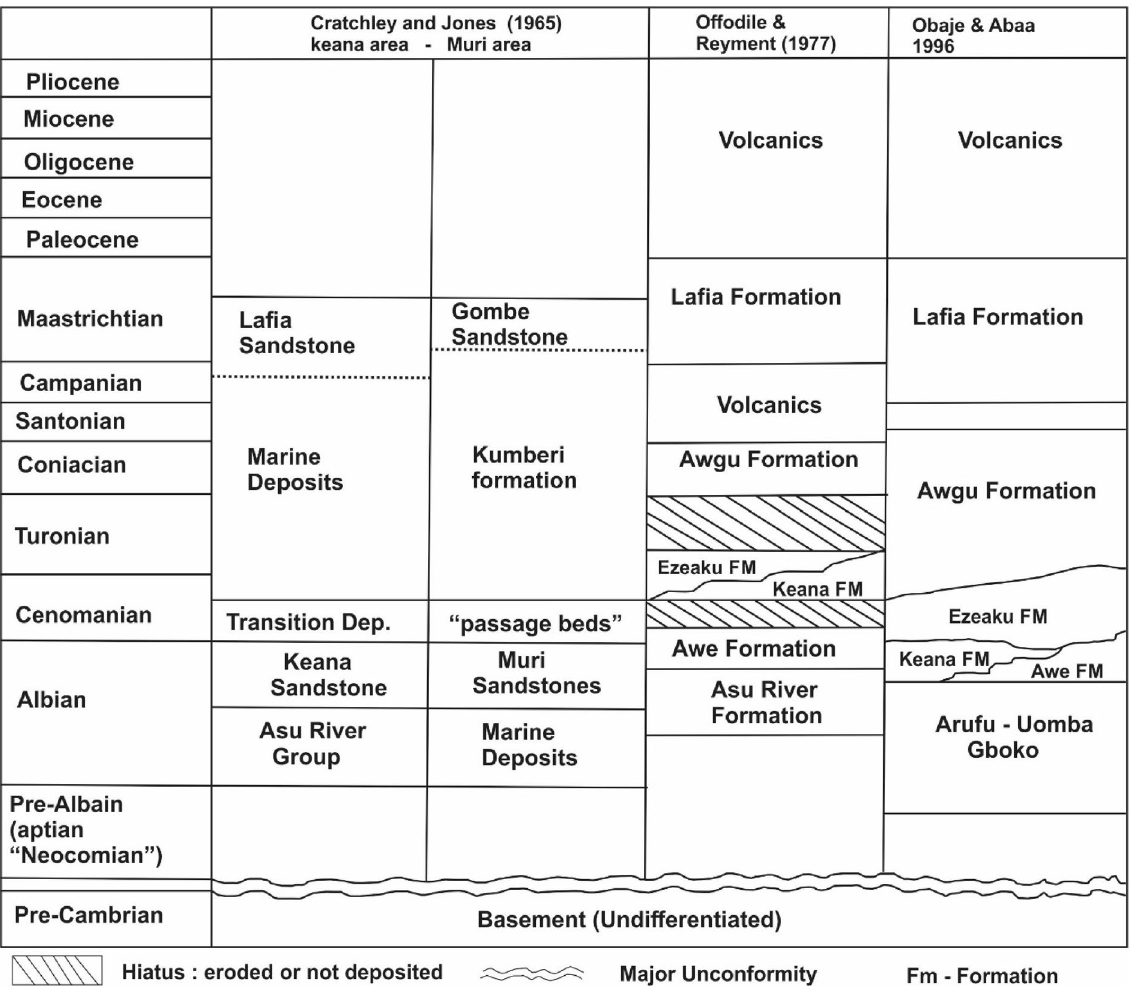
Figure 2. Regional stratigraphy of the mid Benue